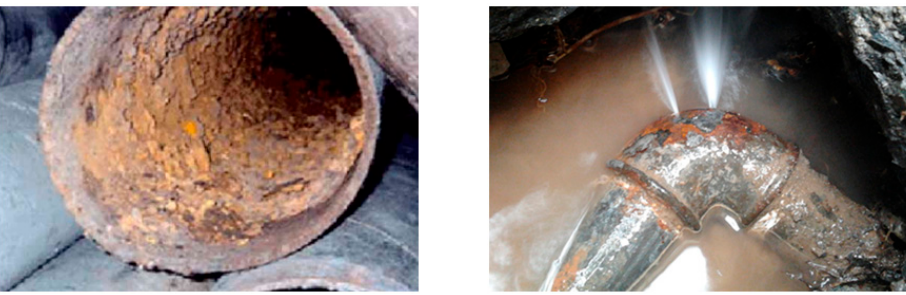
Figure 2. Pipeline corrosion and leakage diagram.